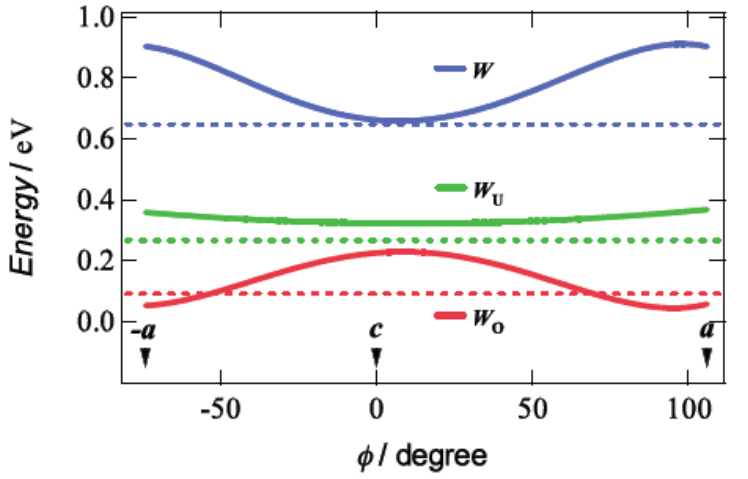
Figure 11. Pressure-orientation dependence of W , W values of W , W and W at ambient pressure are indicated by the dotted lines (Reprinted U O with permission from reference 21, American Chemical